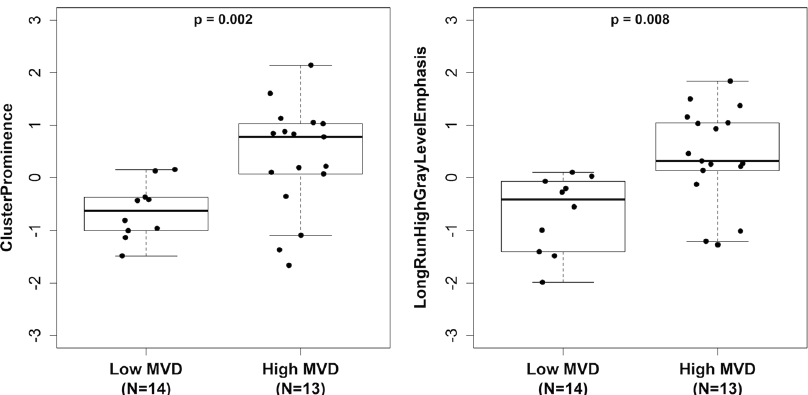
Fig. 3 DCE-MRI radiomics features most associated with microvessel density. Two radiomic texture features that signi fi cantly differentiated lesions with low versus high microvessel density (MVD). Box-and-whisker plots represent the median (solid line), inter-quartile range (IQR; box) and range of the radiomics features. The whiskers extend up to 1.5 times the IQR from the box to the smallest and largest points. Radiomics features were log-transformed to reduce skewness and standardized to have a standard deviation equal to 1. Lesions with higher MVD based on CD31 staining on average demonstrated higher GLCM — ClusterProminence values (AUC: 0.84, p = 0.002, left) and higher GLRLM — LongRunHighGrayLevelEmphasis values (AUC: 0.83, p = 0.003, right).